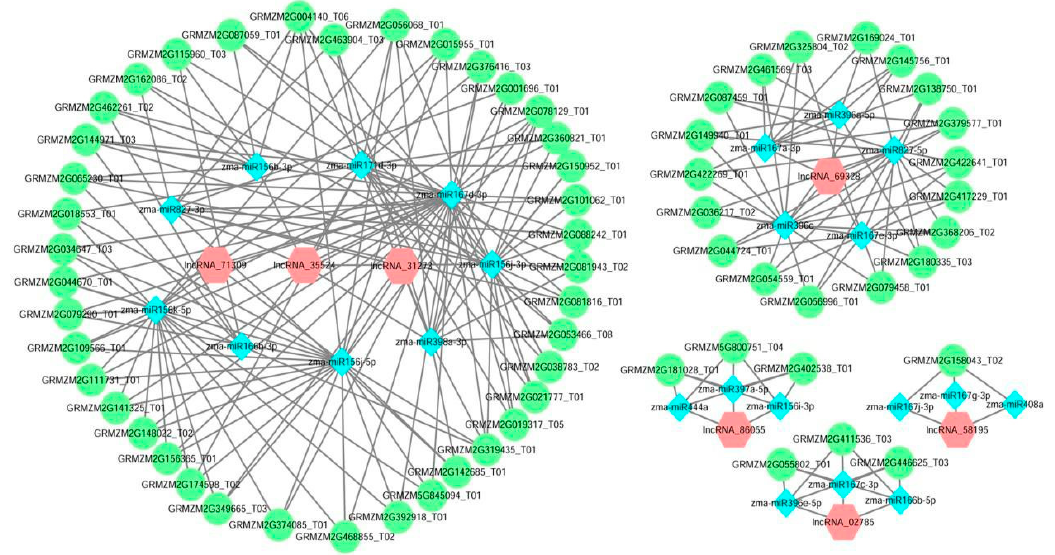
Figure 5. Co-expression network of lncRNA-miRNA-mRNA and ceRNA. The network was constructed based on ceRNA score (score ≥ 1, p -value < 0.01). Diamond nodes represent miRNAs, circles represent mRNAs, and rectangles represent